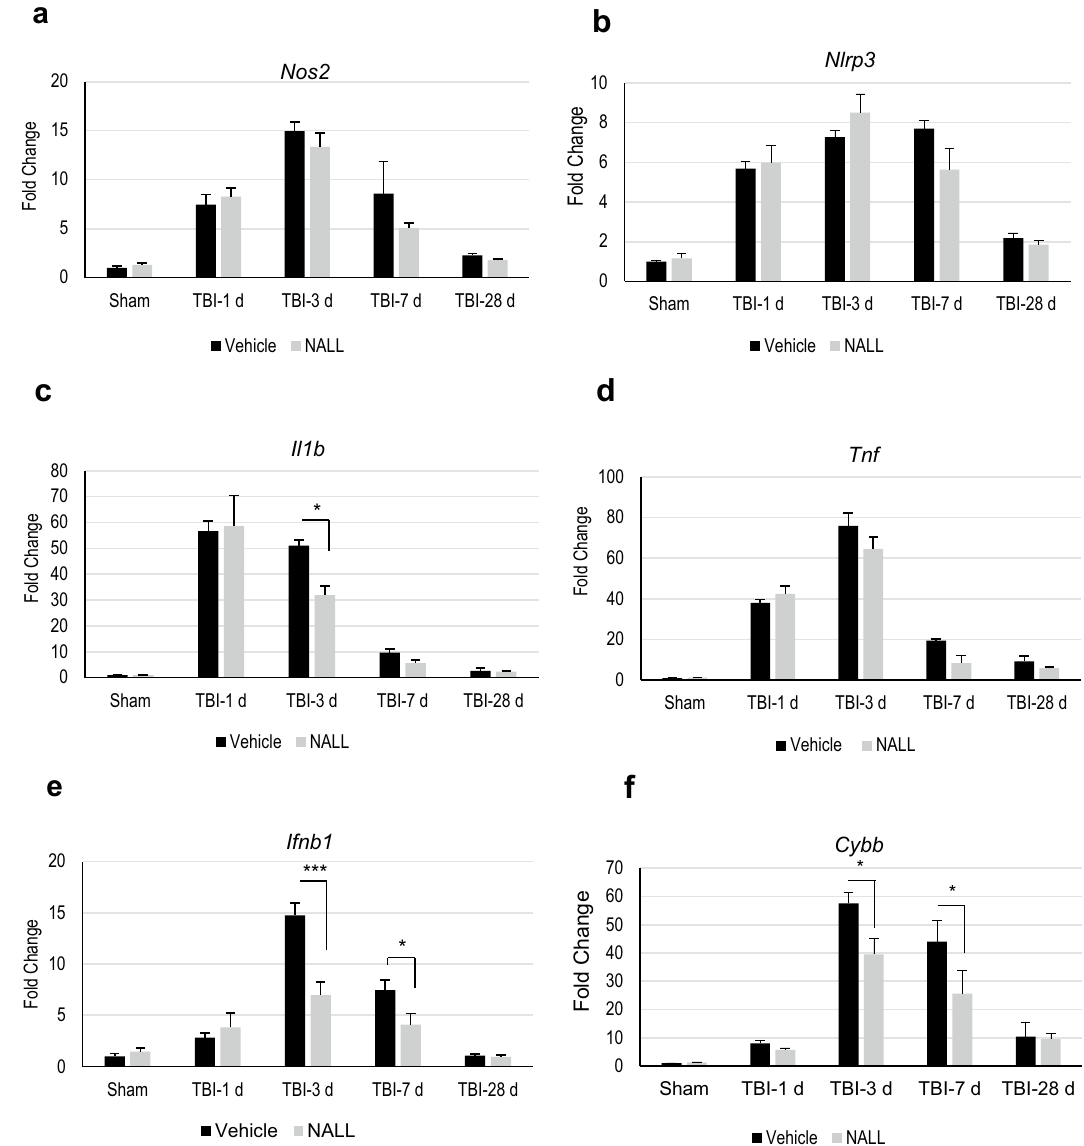
Figure 4. NALL reduces pro-inflammatory markers in the injured mouse cortices. Relative mRNA levels of ( a ) iNOS ( Nos2 ), ( b ) NLRP3 ( Nlrp3 ), ( c ) IL-1β ( Il1b ), ( d ) TNF ( Tnf ), ( e ) IFN-β ( Ifnb1 ) and ( f ) NOX2 ( Cybb ) in the cortices of sham and TBI mice fed with NALL or vehicle. Data are presented as mean ± SEM. n = 5/group, ***p < 0.001, *p < 0.05 (Two-way ANOVA with Bonferroni